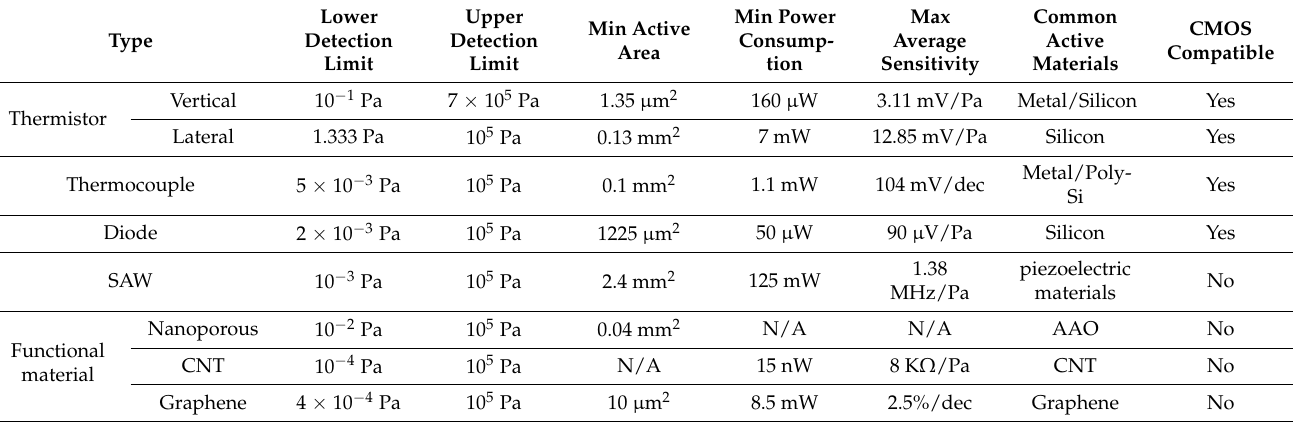
Table 1. The properties of different type MEMS Pirani